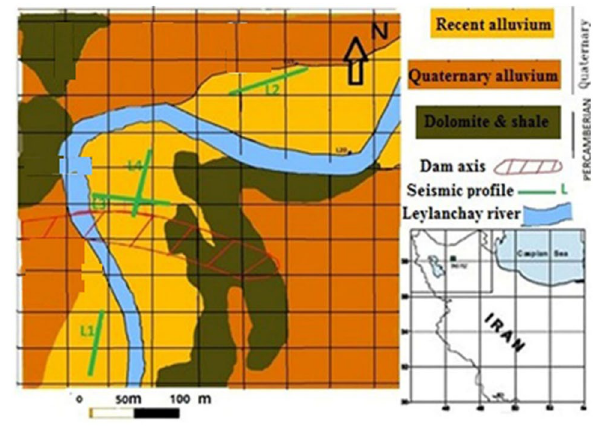
Fig. 5 Geological map of the study area [27]